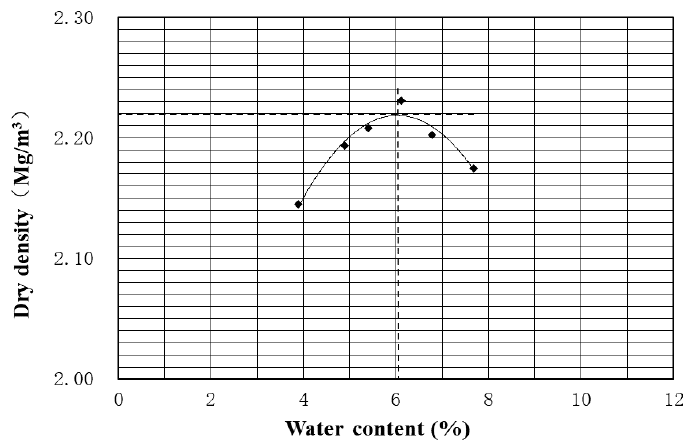
Figure 3. Modified Proctor compaction curve.